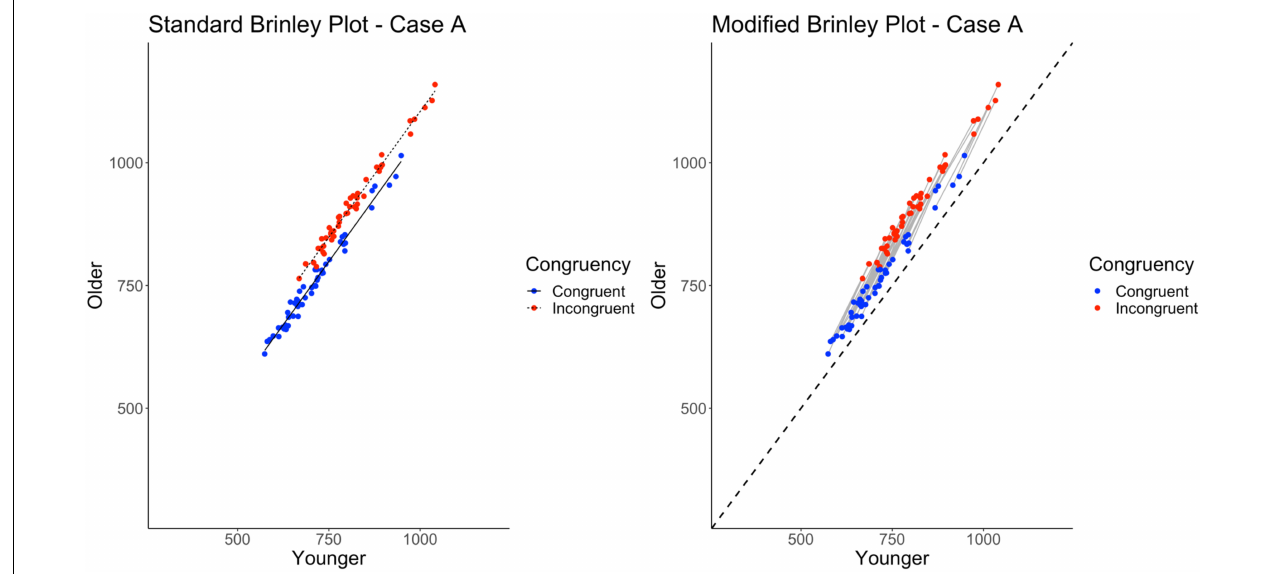
FIGURE 3 | Standard and modified Brinley plots—Case A data. Standard and modified Brinley plots (left and right, respectively) for the Case A simulated data which was simulated such that all studies had the same interaction. Means (SD) used for Case A were as follows: Young Congruent = 700 (150), Young Incongruent = 800 (150), Old Congruent = 750 (200), Old Incongruent = 900